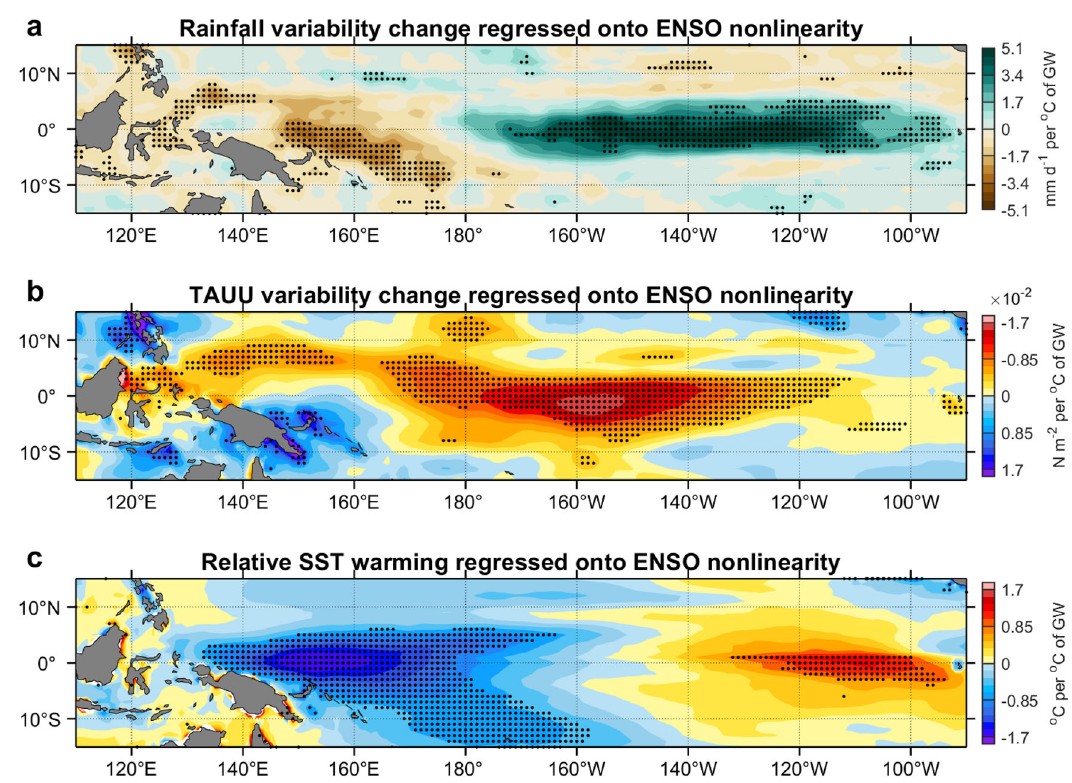
Fig. 5| Strongereastern-Paci fi cElNiño-SouthernOscillation(EP-ENSO)change signalboostedbystrongernon-linearBjerknesfeedback. Inter-modelregression of a grid-point rainfallvariability change (1960 – 2030minus piControl, mm d − 1 per °C of global warming), b grid-point zonal wind stress (TAUU) variability change (1960 – 2030minus piControl, N m − 2 per °C of global warming) and c relative sea